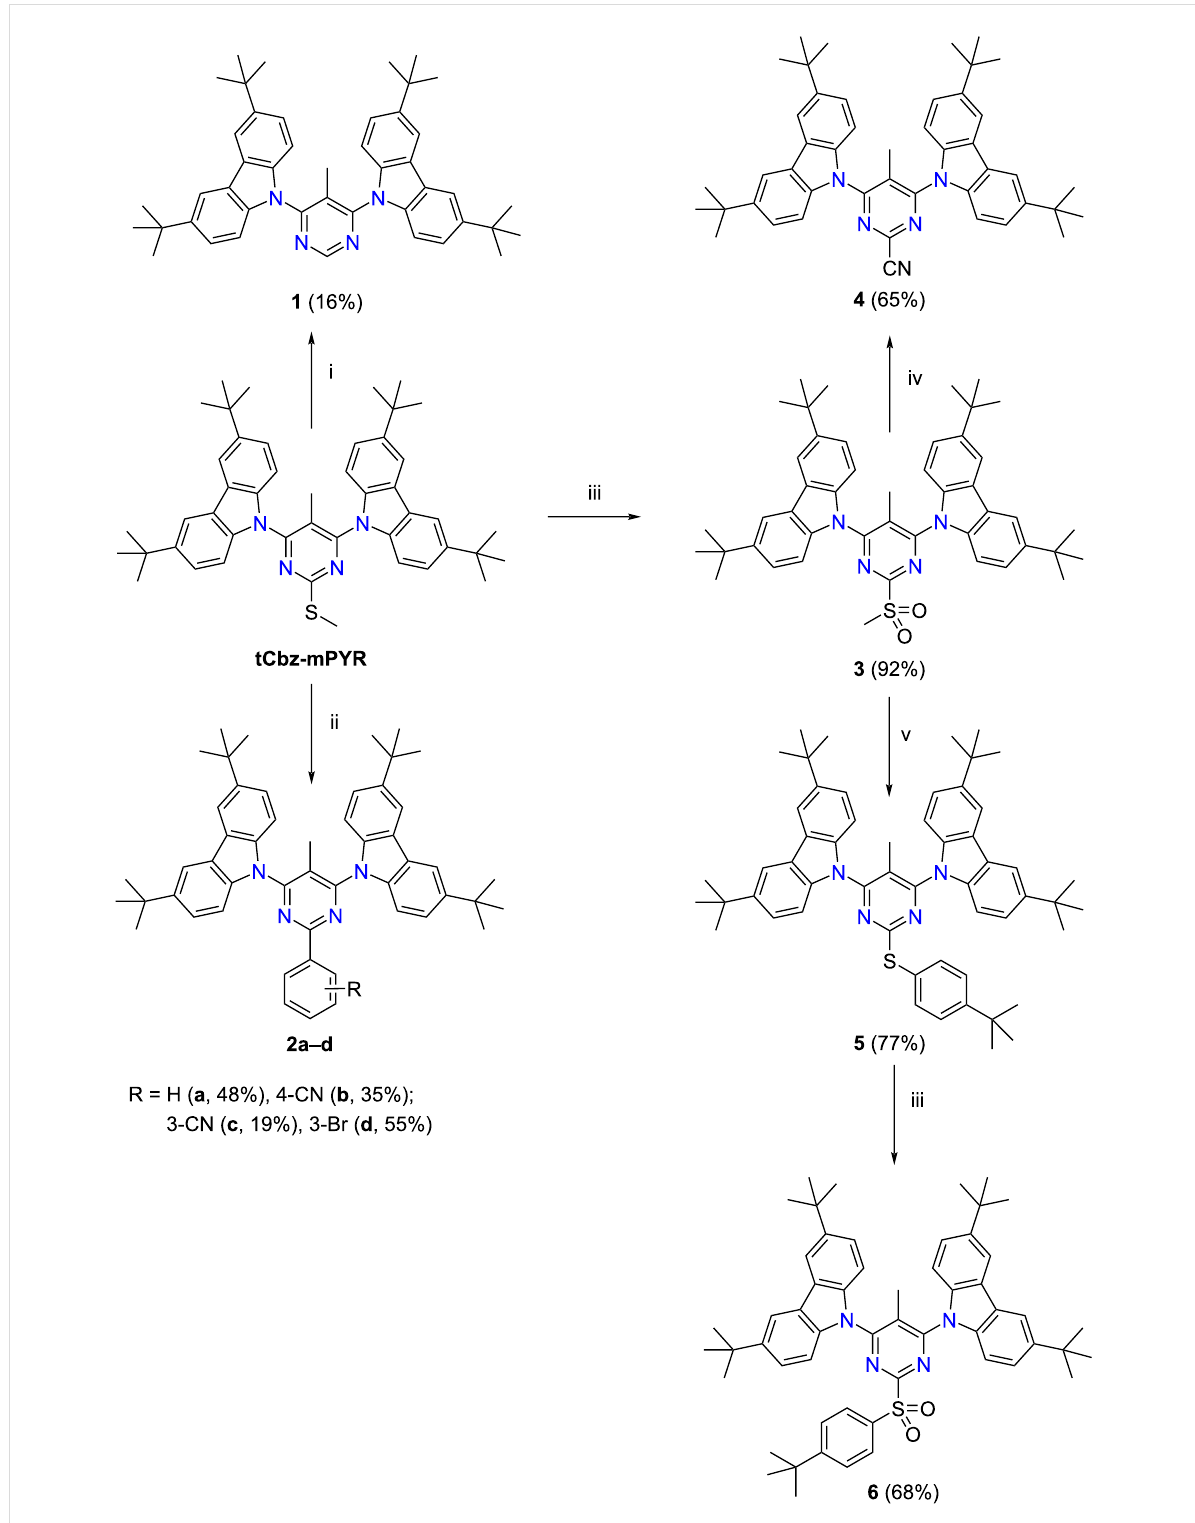
Scheme 1: Synthesis of 4,6-bis(3,6-di- tert -butyl-9 H -carbazol-9-yl)-5-methyl-2-substituted pyrimidines 1 – 6 . Reagents and conditions: i – Raney Ni, MeOH, 90 °C, 2 h; ii – arylboronic acid (1.3 equiv), Pd(PPh 3 ) 4 (5 mol %), Cs 2 CO 3 (2 equiv; 1 equiv in case of meta -substituted boronic